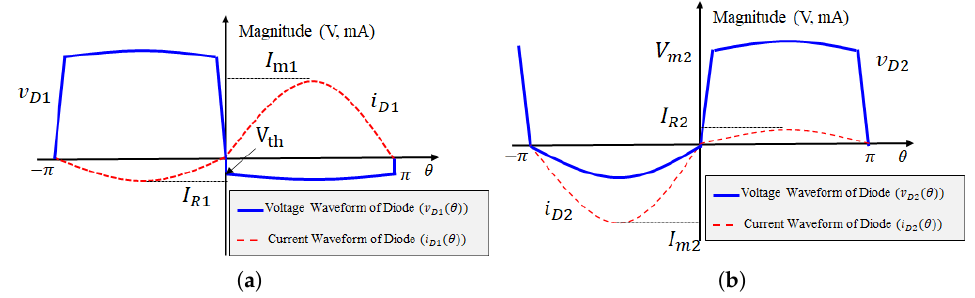
Figure 3. One-stage HTVM circuit diagram and diode waveforms over the breakdown voltage; ( a ) voltage and current waveform of diode D 1 ; ( b ) voltage and current waveform of diode D 2 . Assuming that the voltage and current of the diode for one cycle in the high power region are v D 1 , v D 2 , i D 1 , and i D 2 , the following equations are b r b r b r b r